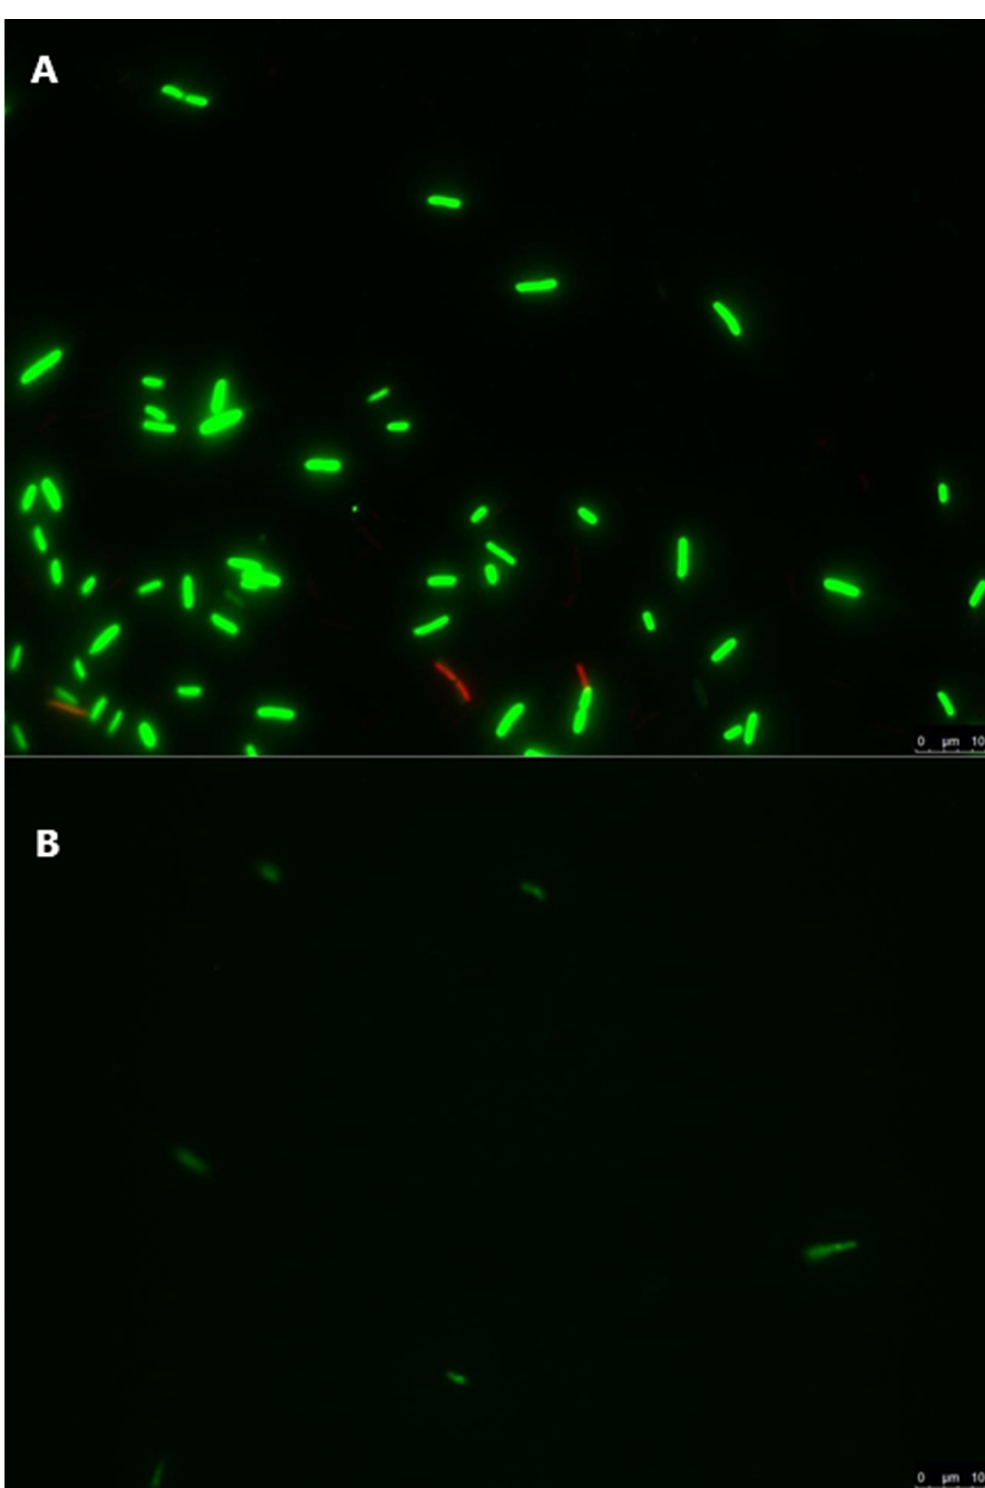
Figure 3. E. coli Lys9 StrepR inoculated in stored irrigation water microcosms, labelled with a live/dead staining protocol. Green-labelled cells are live, and red-labelled cells are injured or dead. The scale bar on each picture represents 10 µm. ( A ) E. coli Lys9 StrepR immediately after inoculation in stored irrigation water microcosms. ( B ) E. coli Lys9 StrepR 35 days after inoculation in stored irrigation water microcosms.